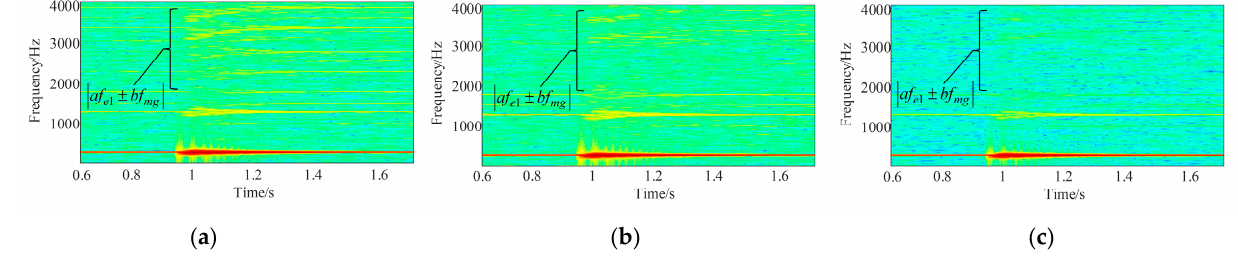
Figure 22. Time-frequency domain of the stator current of motor 1 with different values of motor shaft stiffness: ( a ) case 3; ( b ) case 2; ( c ) case 1.